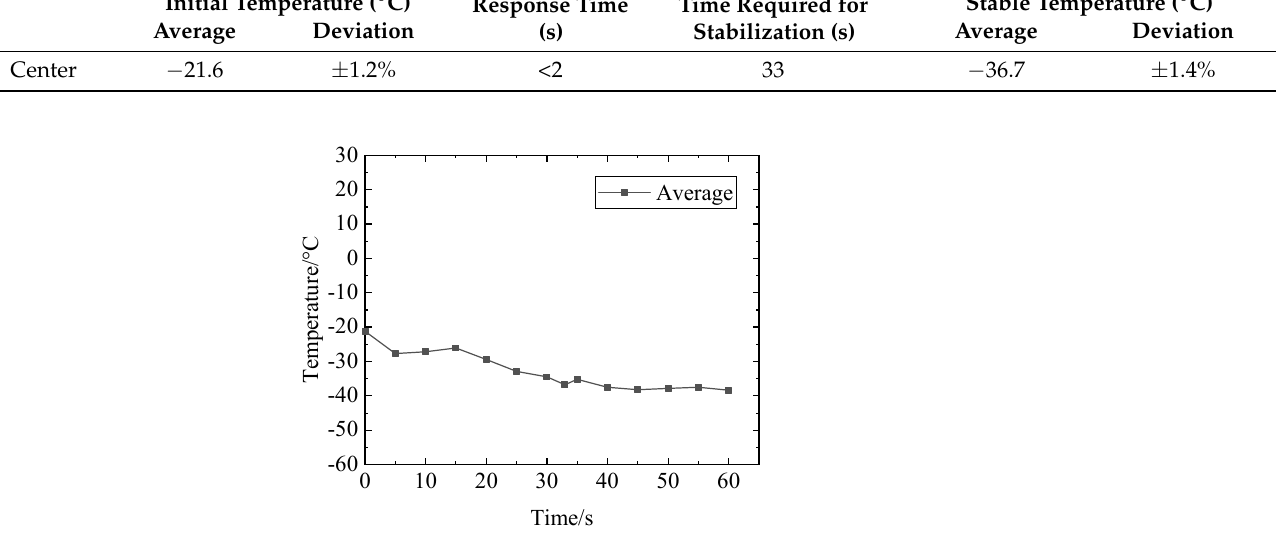
Figure 13. Variation curve of temperature over time in the response phase. After stabilization, the outlet temperature is maintained between − 60 °C and − 70 °C. The temperature dropped to − 60 °C when the solenoid valve closed and to − 70 °C when the sole- noid valve opened. The required liquid nitrogen flow rate to maintain the heat flux of 850 W/m 2 was estimated to be 0.36 L/min through the temperature recovery time of the aluminum plate and energy conservation in the stable stage. Only 11.07 L of liquid nitrogen was used for 30 min after stabilization. Figure 14 shows the infrared image changing with time.